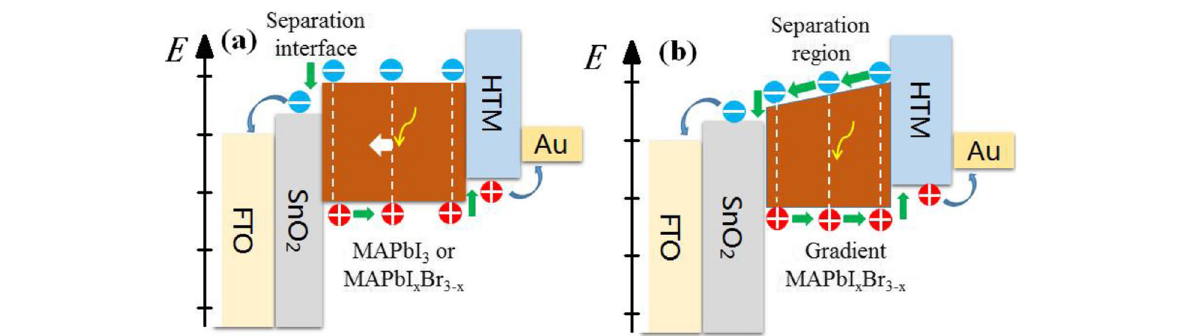
Fig. 6 Schematic diagrams of the working principle for different PSCs. a PSC without a gradient type-II band structure. b PSC with a gradient band